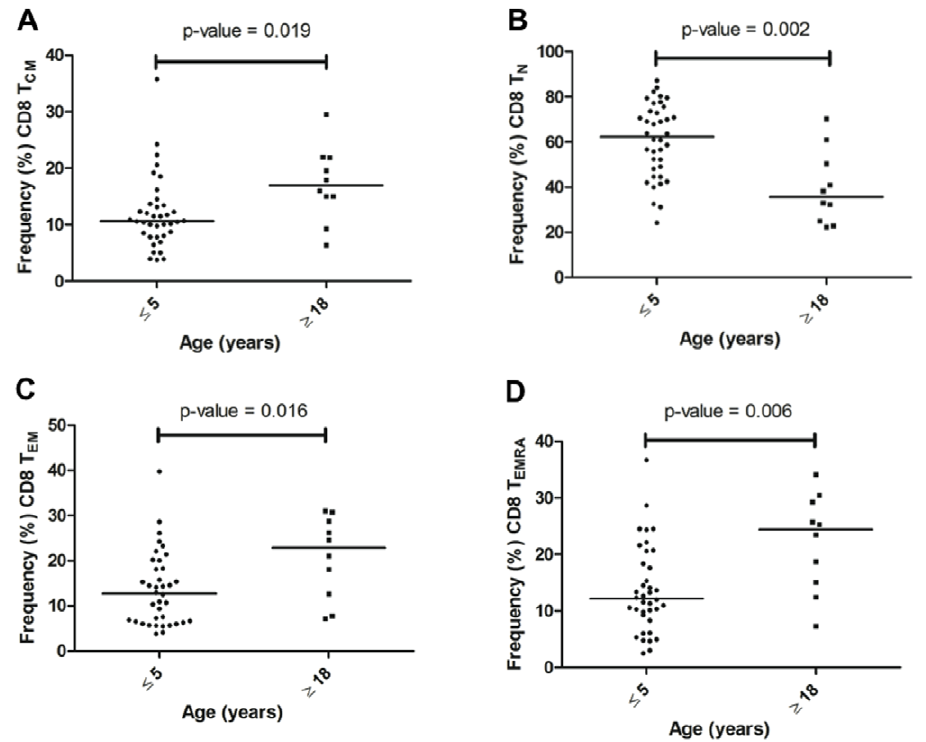
Figure 4. Proportion of resting CD8 T cell subsets across age groups. The frequency of each T cell subset was compared between adults ( $ 18 years old) and children ( # 5 years old) for ( A ) Central memory, T CM : CD8 + CD45RA 2 CD62L + ; ( B ) naı¨ve T cells, T N : CD8 + CD45RA + CD62L + ; ( C ) effector memory, T EM : CD8 + CD45RA 2 CD62L 2 ; and ( D ) RA-expressing effector memory, T EMRA : CD8 + CD45RA + CD62L 2 . The median frequency of CD8 + T CM , T EM and T EMRA were significantly lower for children compared to adults ( P =0.019, P =0.016 and P =0.006, respectively, Mann Whitney test). In contrast, the median frequency of CD8 + T N was significantly higher for children compared with adults ( P =0.0002).